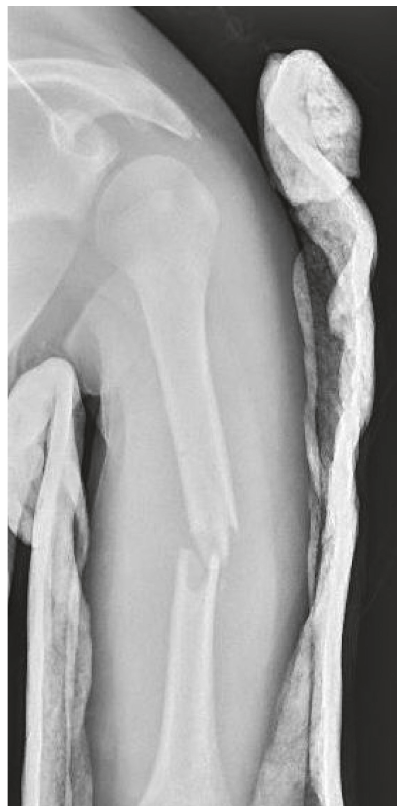
Figure 2: Anteroposterior radiograph following reduction and coaptation splinting showing some mild distraction but overall improvement of alignment of the humerus fracture with acceptable residual 15 ° varus